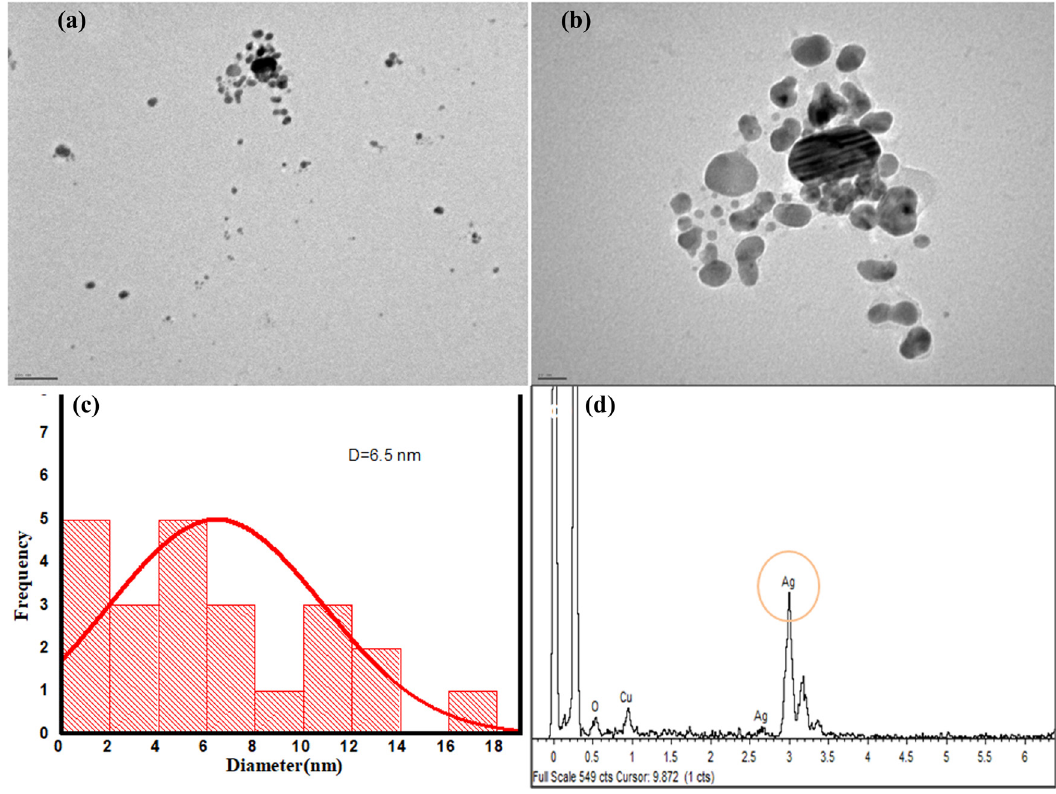
Figure 4: ( a and b ) Low to high magni fi cation TEM images; ( c ) histogram of AgNPs; ( d ) EDS investigation of AgNPs.